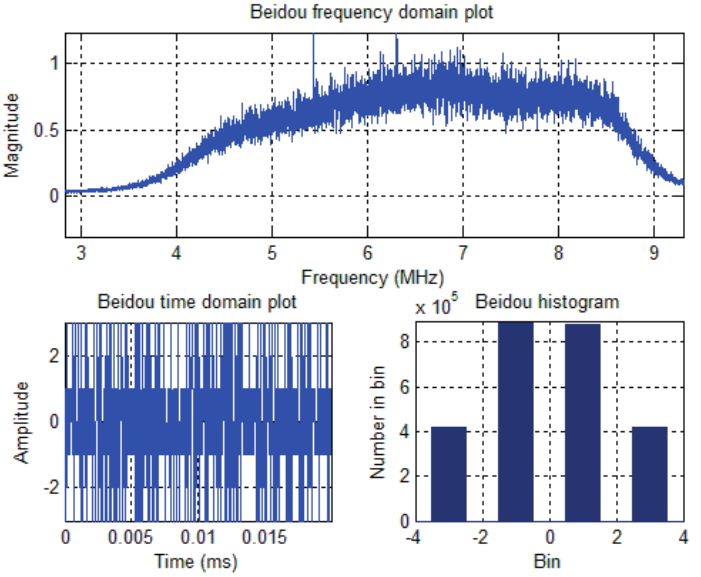
Figure 1. BeiDou signal spectrum ( Top ); time-domain plot ( Bottom-left ); and bin distribution ( Bottom-right ) of the digitized IF samples.